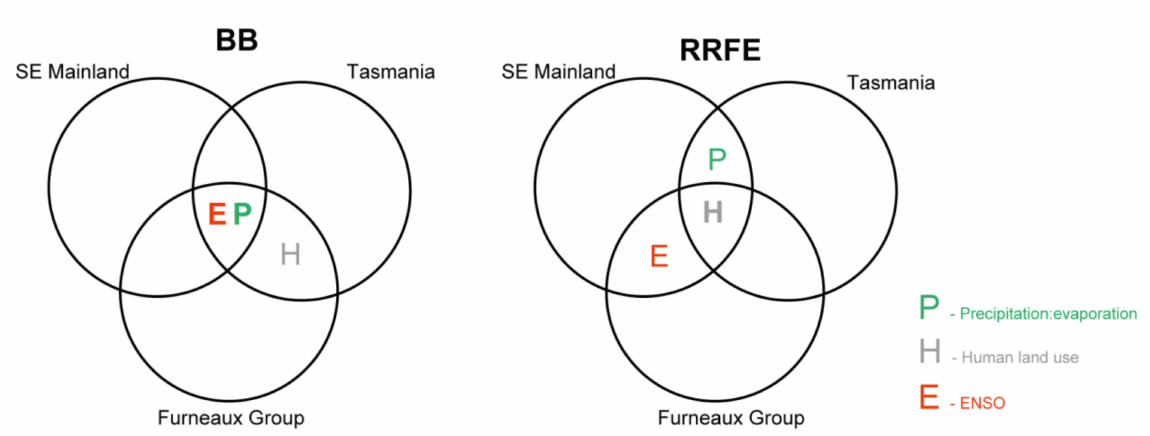
Figure 5. Summary Venn diagrams showing major predictors of Holocene regional biomass burned (BB) and recurrence- rate-of-fire-episodes (RRFE) in southeast Australia, based on GLM results in Table 2. Predictors in bold explain biomass burned/fire frequency across all